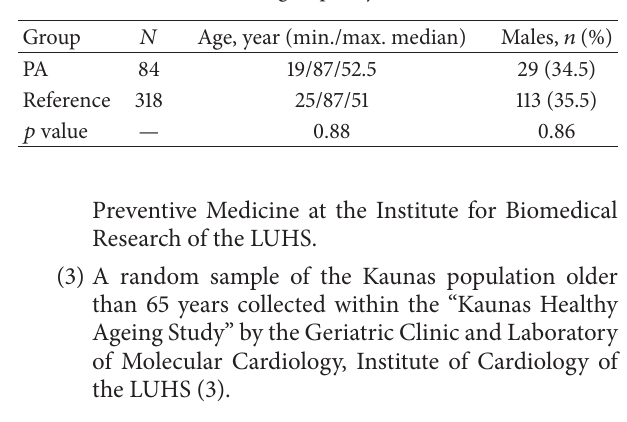
Table 1: Demographic characteristics of patients with pituitary adenoma (PA) and reference group